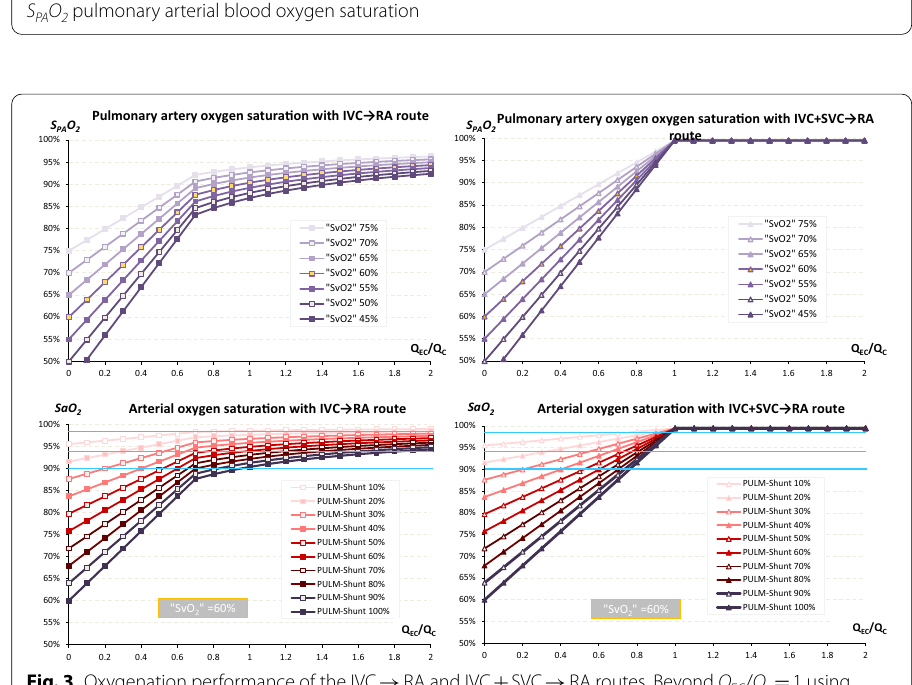
Fig. 3 Oxygenation performance of the IVC RA and IVC SVC RA routes. Beyond Q EC / Q c 1 using → + → = the IVC + SVC RA route, Q Eff reaches the Q c value and cannot increase further. Q EC increases then due → to structural recirculation. IVC inferior vena cava, PULM-Shunt pulmonary shunt, Q EC extracorporeal pump flow, Q Eff effective extracorporeal pump flow, Q C cardiac output, RA right atrium, SaO 2 arterial blood oxygen saturation, S PA O 2 pulmonary arterial blood oxygen saturation, “SvO 2 ” mixed venous blood oxygen saturation, SVC superior vena